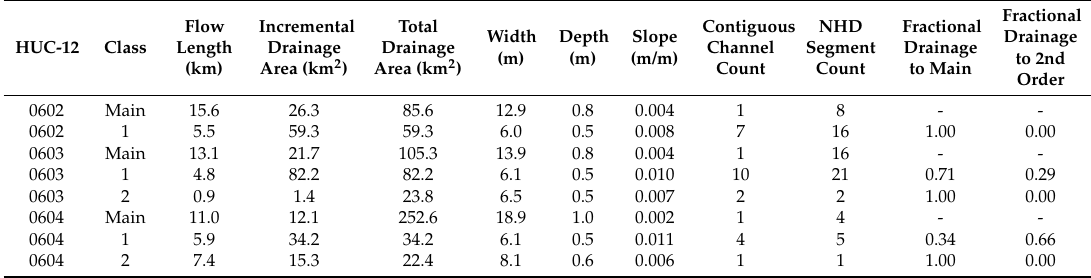
Table 2. Representative channel characteristics for enhanced SWAT+ configuration as depicted in Figure